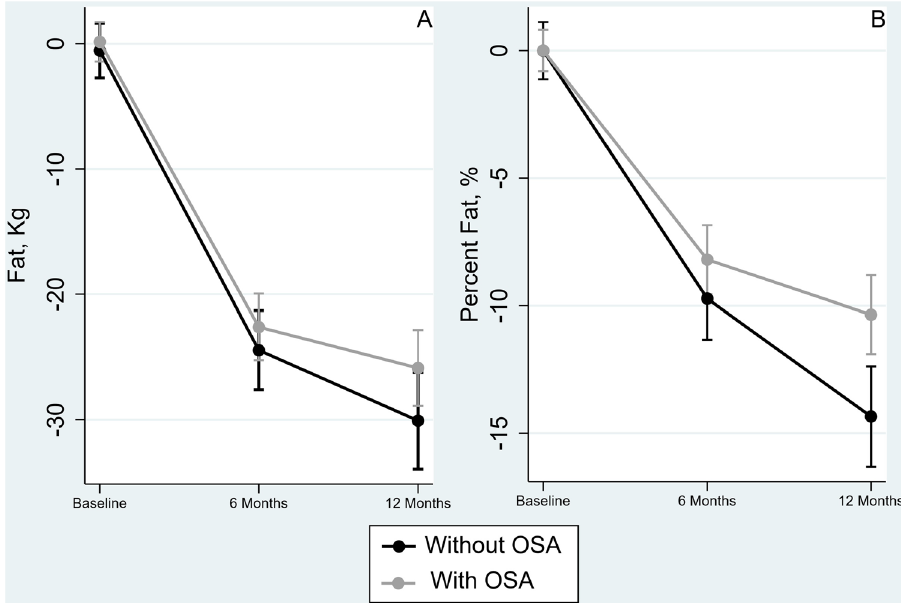
Figure 2. The decrease in body fat ( A ) and percentage of body fat ( B ) at 6 and 12 months after surgery in patients with and without obstructive sleep apnea syndrome